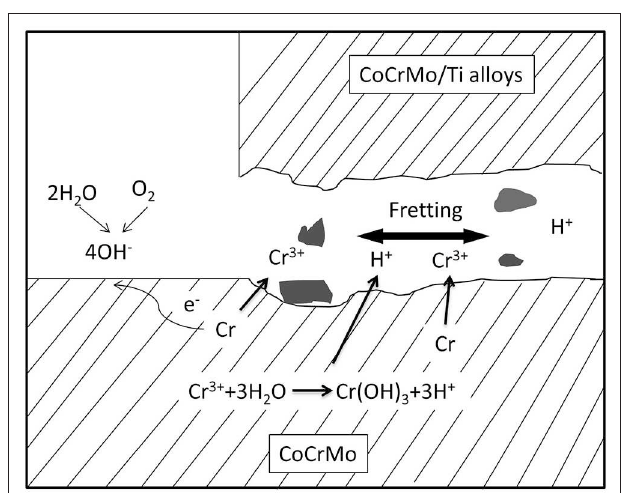
FIGURE 2 | Illustration of fretting corrosion between two metallic components. Fretting corrosion is complexed by crevice corrosion that results in oxygen depletion and reduced pH in the crevice where fretting